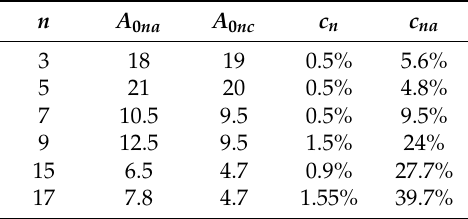
Table 3. The difference between actual and the calculated value of voltage harmonics.